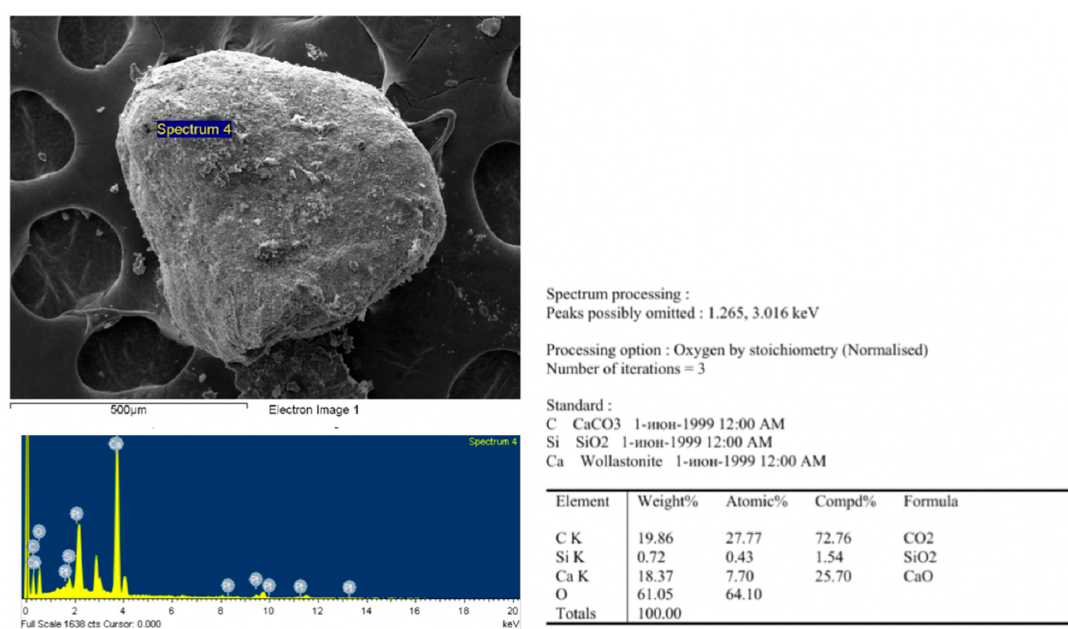
Figure 5. Surface morphology and energy dispersive spectrum of calcite. SEM LEO 1450 VP, Carl Zeiss.